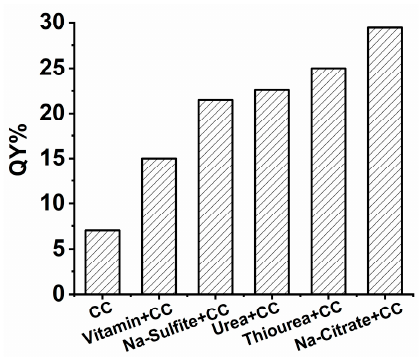
Figure 1. QYs of SiQDs synthesized with single reductant (CC) and double reductants (CC with other reductants).